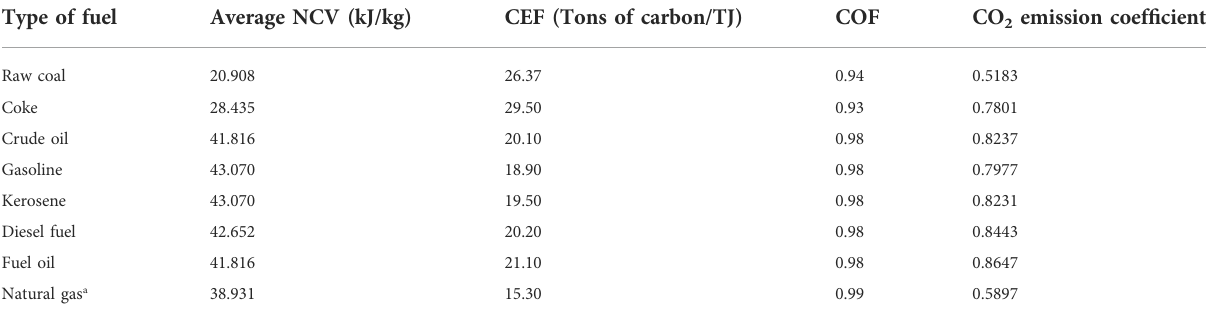
TABLE 1 CO 2 emission coef fi cients for eight types of fossil